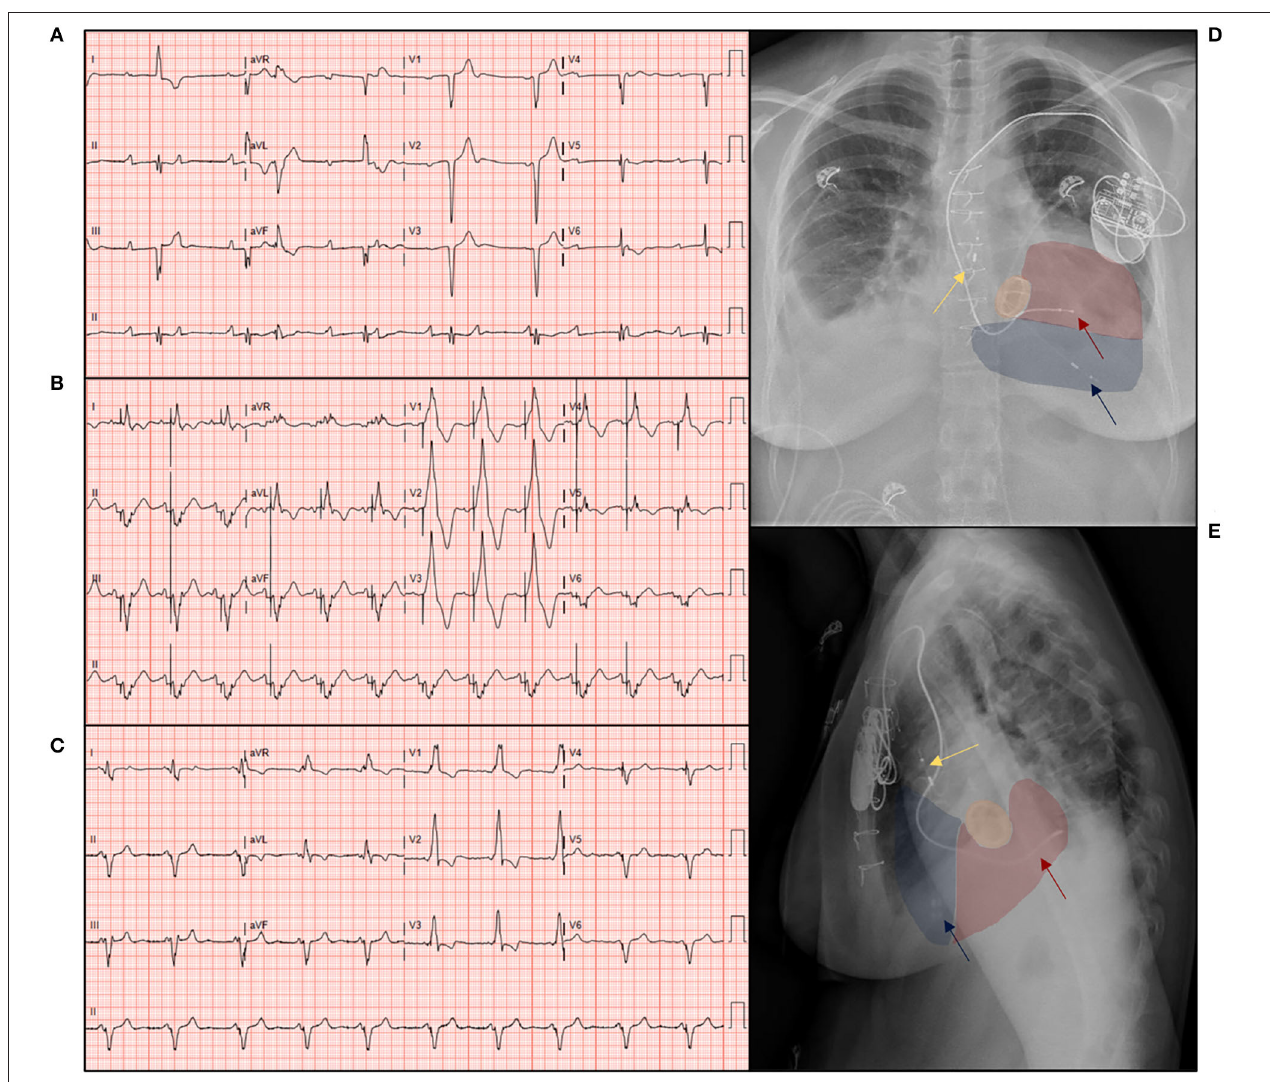
FIGURE 1 | The 12-lead ECG recordings and chest X-rays of a patient with congenitally corrected transposition of the great arteries, illustrating the effects of subpulmonary ventricular pacing, and cardiac resynchronization therapy on an electrocardiogram (ECG). The 12-lead ECG with (A) sinus rhythm and a total atrioventricular (AV)-block with ventricular/junctional escape rate of 48/min; (B) sequential subpulmonary left ventricular pacing of 75/min, note the broad paced QRS complex of 245ms; (C) biventricular pacing after upgrade to a cardiac resynchronization therapy (CRT), note the reduction of QRS duration to 137ms, illustrative of the electrical contribution of the systemic right ventricular (sRV) activation. (D) Postero-anterior, (E) lateral chest X-ray showing the pacing lead in the coronary sinus (red arrow) in the systemic right ventricle (red), atrial lead in the right atrium (yellow arrow), and transvenous pacing and ICD leads (blue arrow) in the subpulmonary left ventricle (LV) (blue), note the mechanical tricuspid valve in situ